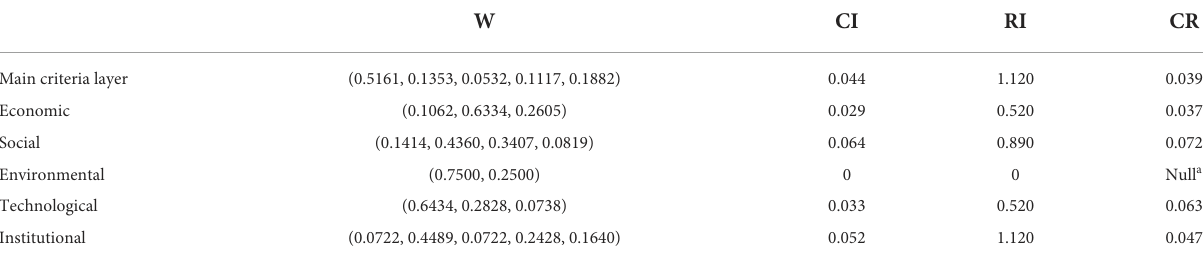
TABLE 5 Eigenvector, largest eigenvalue, consistency indicator, and consistency check coefficient comparison matrices.